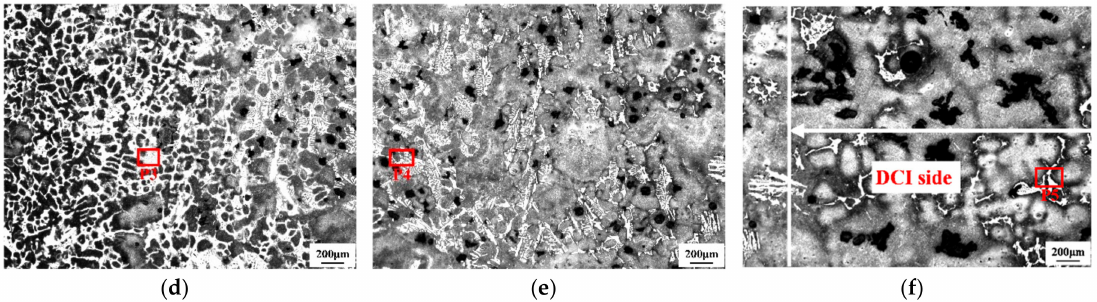
Figure 7. Microstructure in the bonding interface. ( a – f ) → HSS side to DCI side.